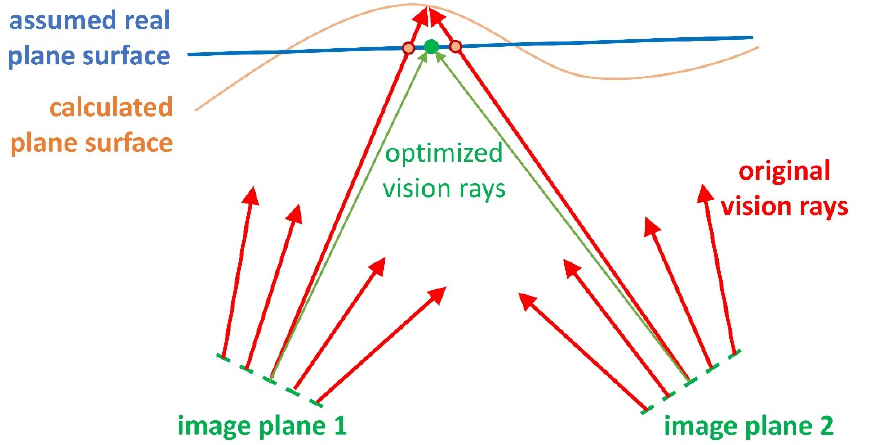
Figure 5. Enforcement of planarity by ray manipulation for one plane.